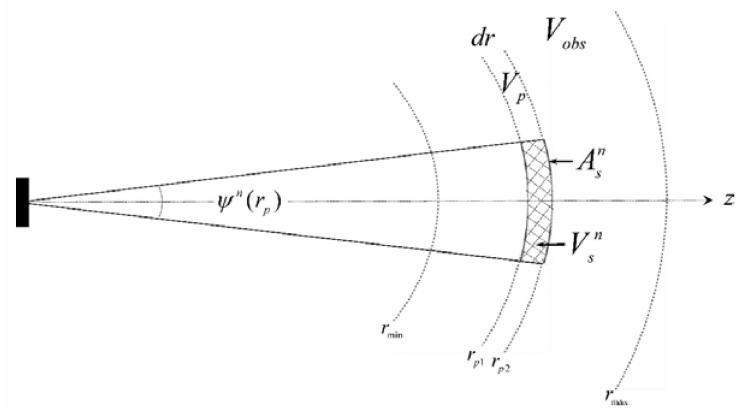
Figure 6. Sketch of the spherical shell sub-volume V p in the spherical shell observation volume, V obs , and the “sampled volume” portion of V p , V n s , which is determined by the intersection of V p and the solid angle ψ n